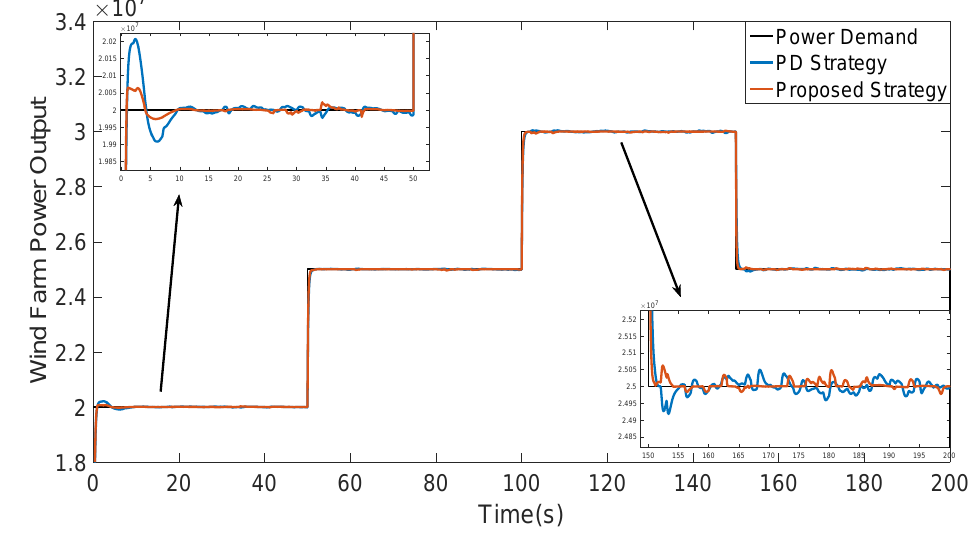
Figure 4. Wind farm active power output comparison.